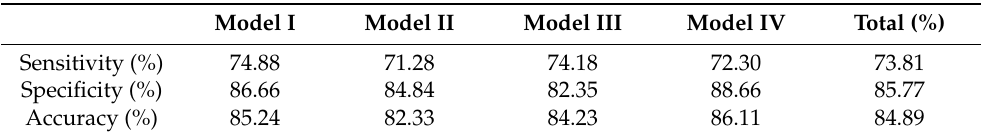
Table 6. Statistical indexes and AUC value of the hybrid